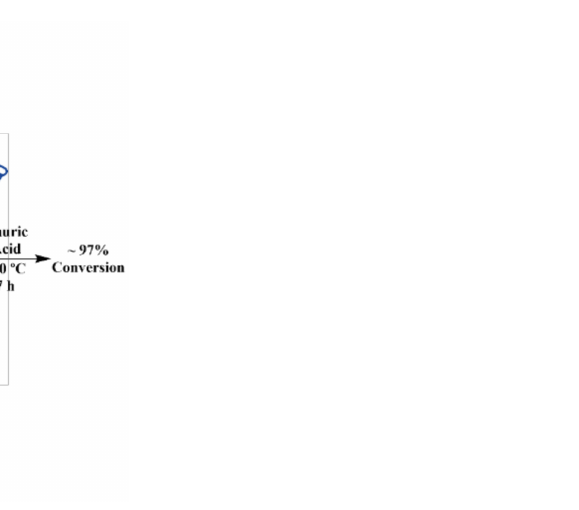
Figure 17. Fatty acid esterification with 1-butanol over Niobium phosphate. Reaction conditions: 1-butanol: fatty acid molar ratio (10:1), catalyst (10% w / w in relation to the fatty acid), temperature (120 ◦ C), time (7 h) (adapted from [9]).